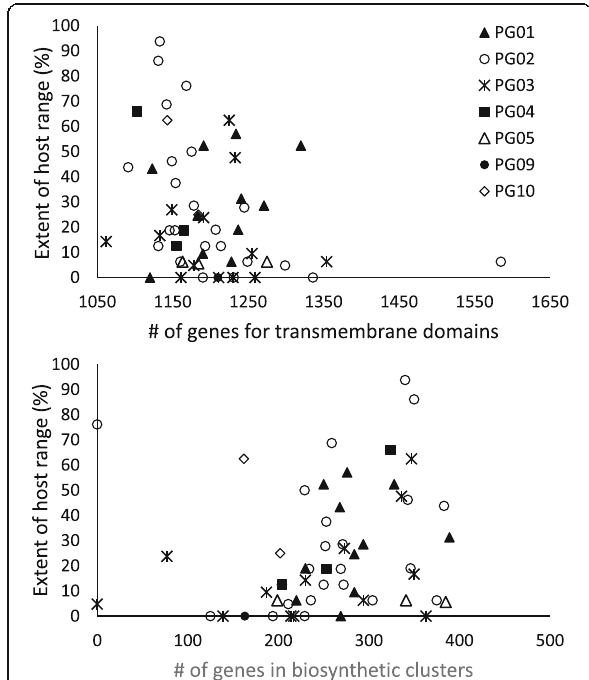
Fig. 7 The extent of host range of 56 strains of Pseudomonas syringae , for which whole genome sequences are available, as a function of genomic features annotated by the Joint Genome Institute Integrated Microbial Genomes and Microbiome System (https://img.jgi.doe.gov). The phylogroup (PG) of each strain is indicated for the seven phylogroups represented by this set of strains. The genomic traits presented here are those for which there were statistically significant ( P < 0.05) correlations, based on Spearman ’ s Rank Order Correlation. For all strains considered together, the extent of host range is significantly correlated with the number of genes for transmembrane domains (correlation coefficient= − 0.330) and the number of genes in biosynthetic clusters (correlation coefficient =